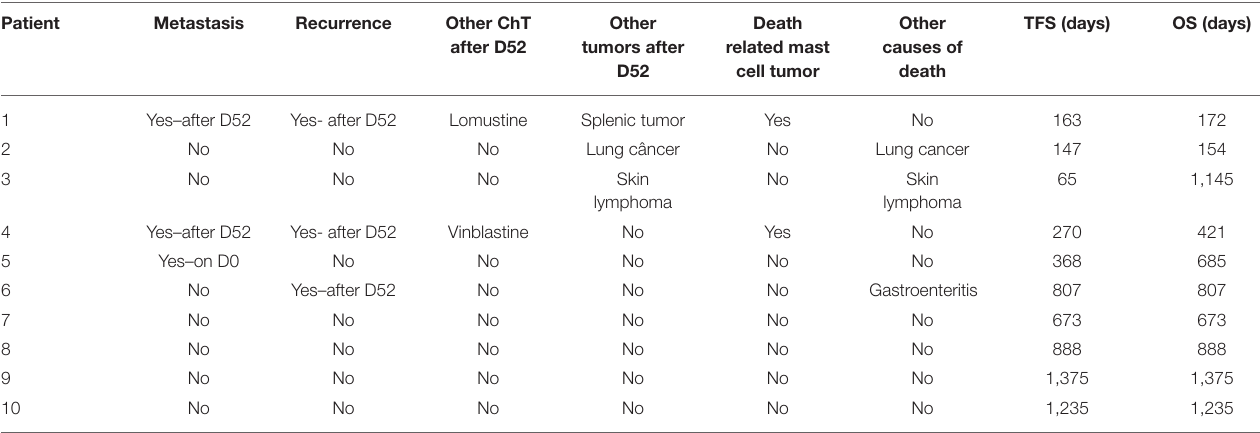
TABLE 4 | Progression of dogs submitted to treatment with